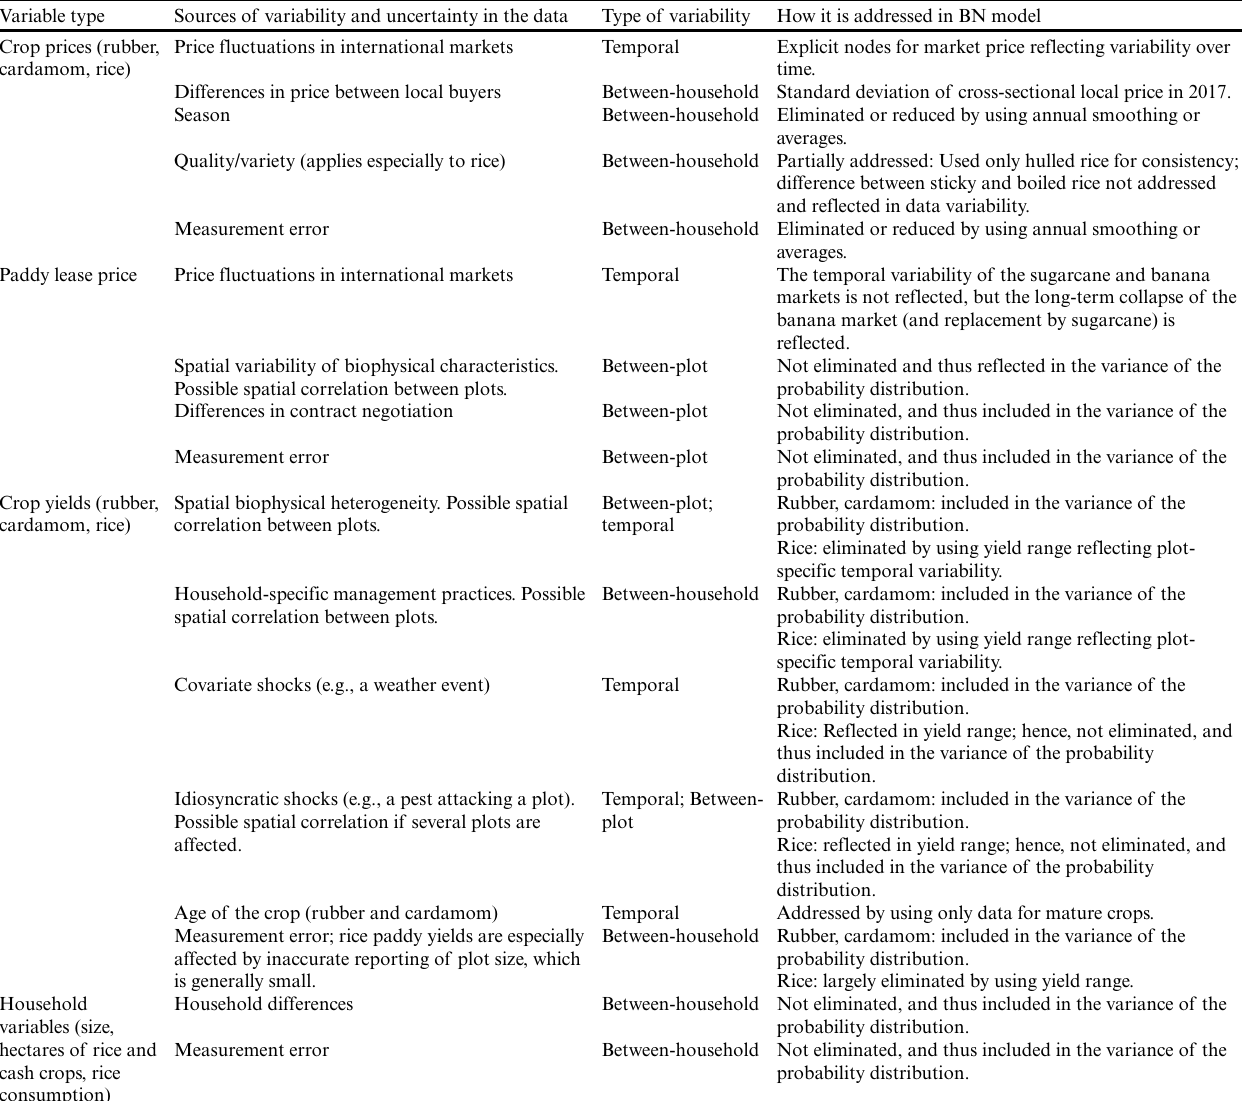
Table 2 . Sources of variability and uncertainty in the data and how they are addressed in the Bayesian network (BN). Variable